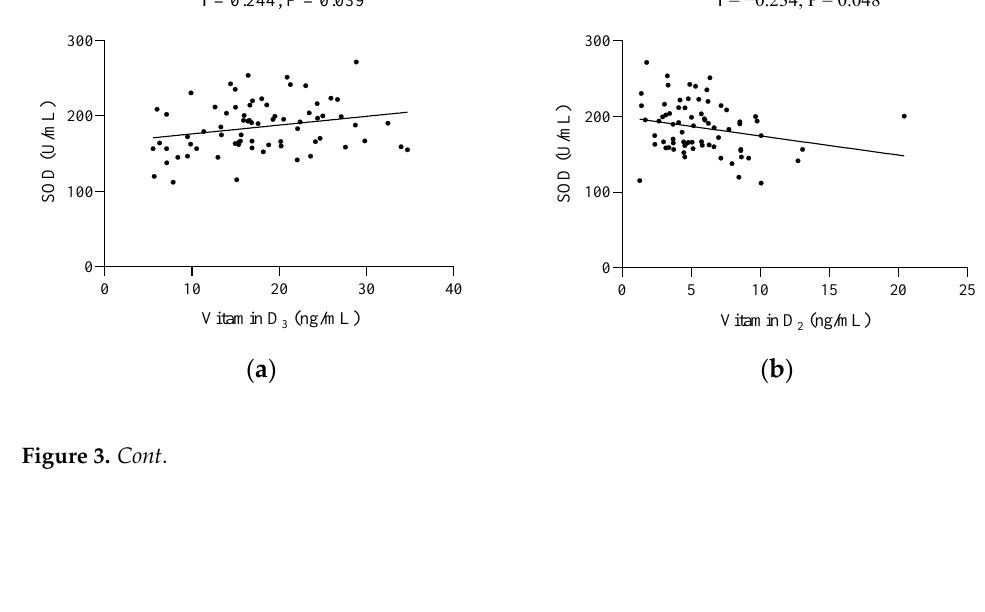
Figure 2. Significant associations of the body composition and biochemical parameters of the study with GPx. ( a ) glucose and GPx, ( b ) glutamic pyruvic transaminase and GPx, ( c ) gamma-glutamyl transferase and GPx, and ( d ) magnesium and GPx. r, Pearson’s correlation coefficient. A p -value less than 0.05 was considered significant. Abbreviations: GPx, glutathione peroxidase; GPT, glutamic pyruvic transaminase; GGT, gamma-glutamyl transferase; Mg, magnesium.